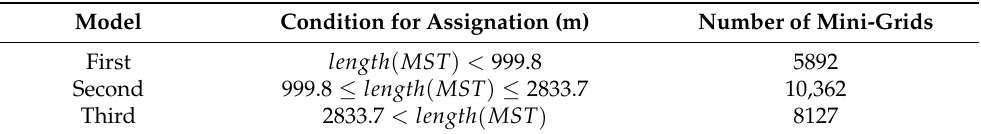
Table 3. Mini-grids assigned to each model.